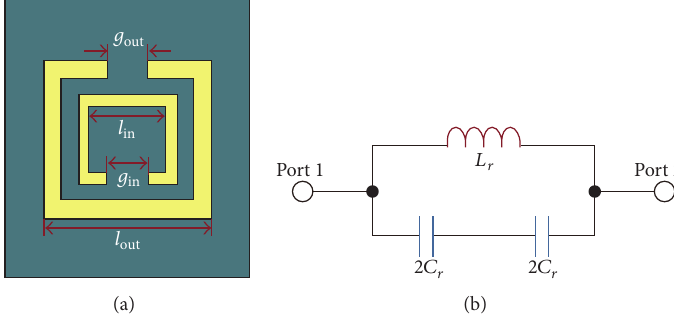
Figure 3: The physical structure (a) and the equivalent circuit (b) of CSRRs.